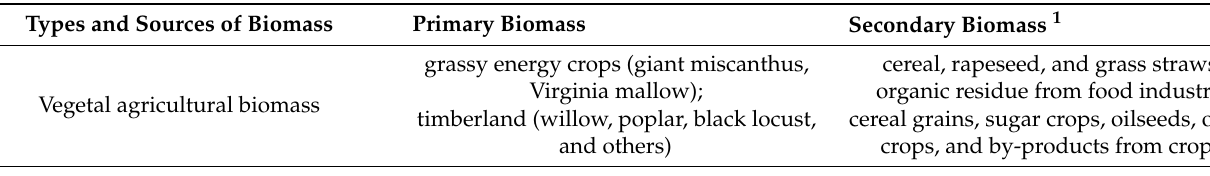
Table 1. Sources of biomass for energy.